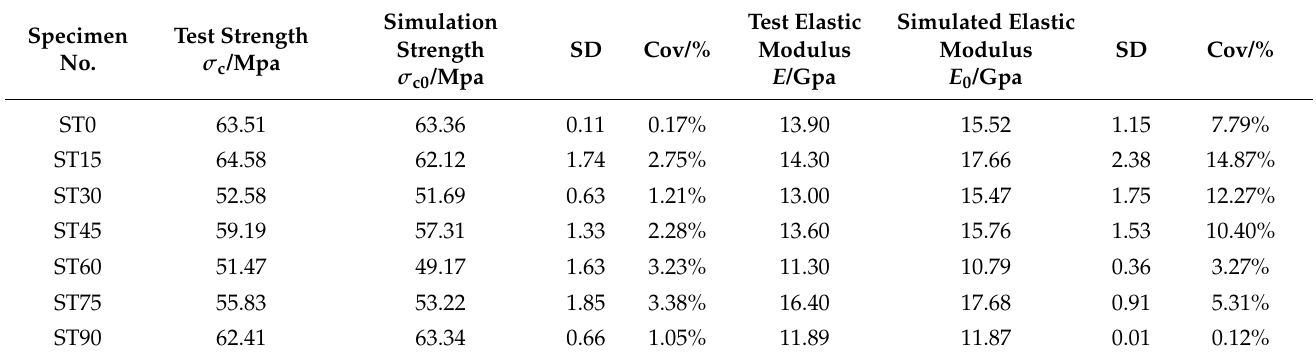
Table 4. Comparison of test and simulation results of mechanical properties of sandstone speci- mens.